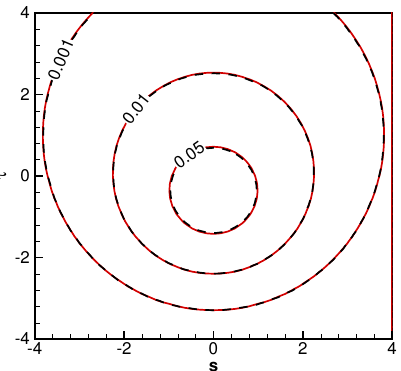
Figure 21. Diffuse plate, heat flux, C q , d ( s , τ ) , S 0 = 2.0, T w / T 0 = 1.5, α 0 = 60 ◦ . Plate lengths are normalized by the nozzle diameter. Solid: analytical; dashed: